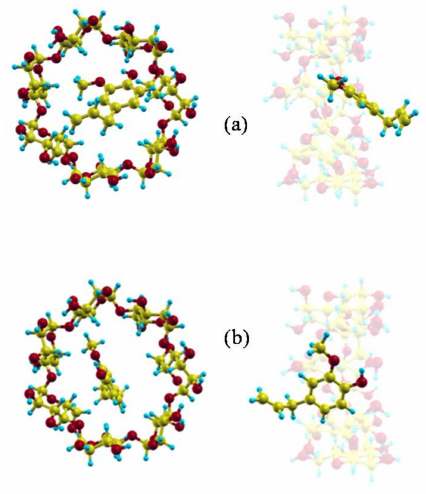
Figure 6. The most probable guest orientations corresponding to the preferred centre of mass positions: ( a ) near the wider rim of β -CD; ( b ) near the narrower rim of β